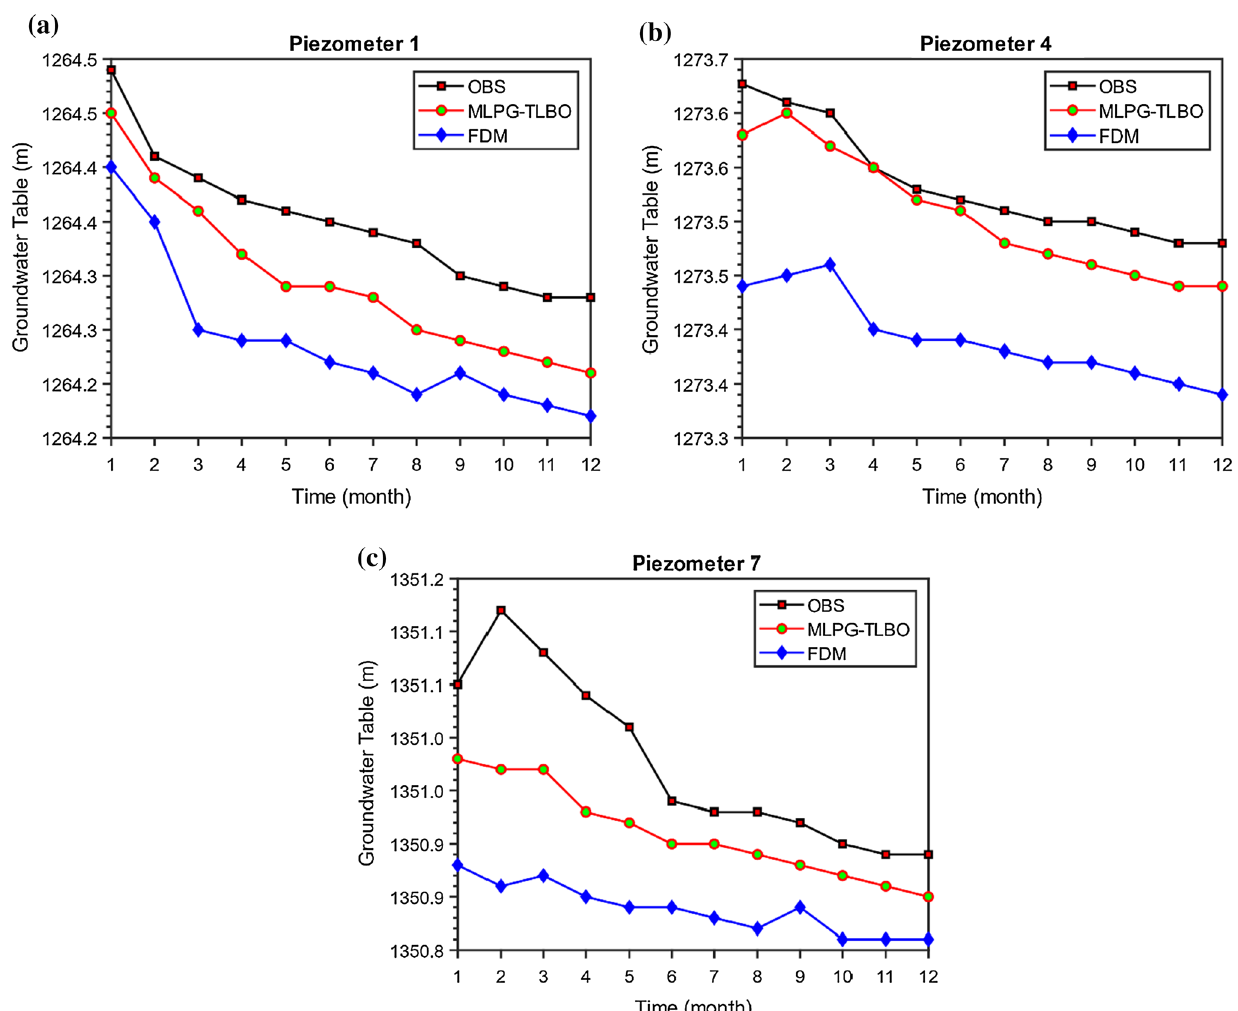
Fig. 7 Computation of groundwater head with